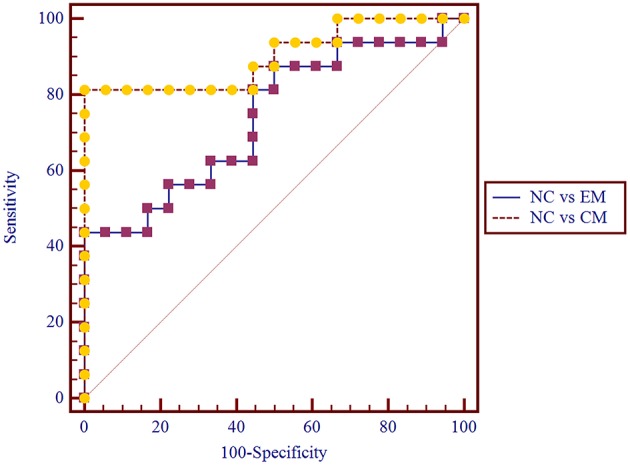
Pairwise comparison of ROC curve for NC vs. EM and NC vs. CM. The AUC for NC vs. CM was 0.90 ± 0.06, and for NC vs. EM was 0.77 ± 0.08.